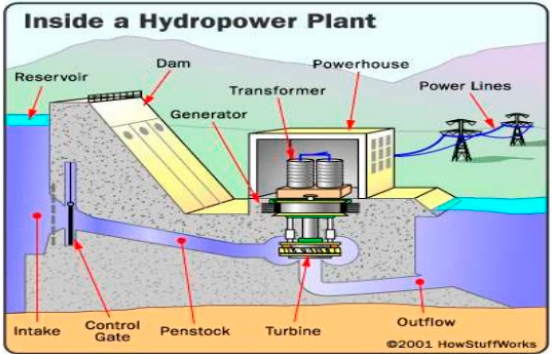
Figure 1. Schematic representation of a reservoir hydropower facility [7].